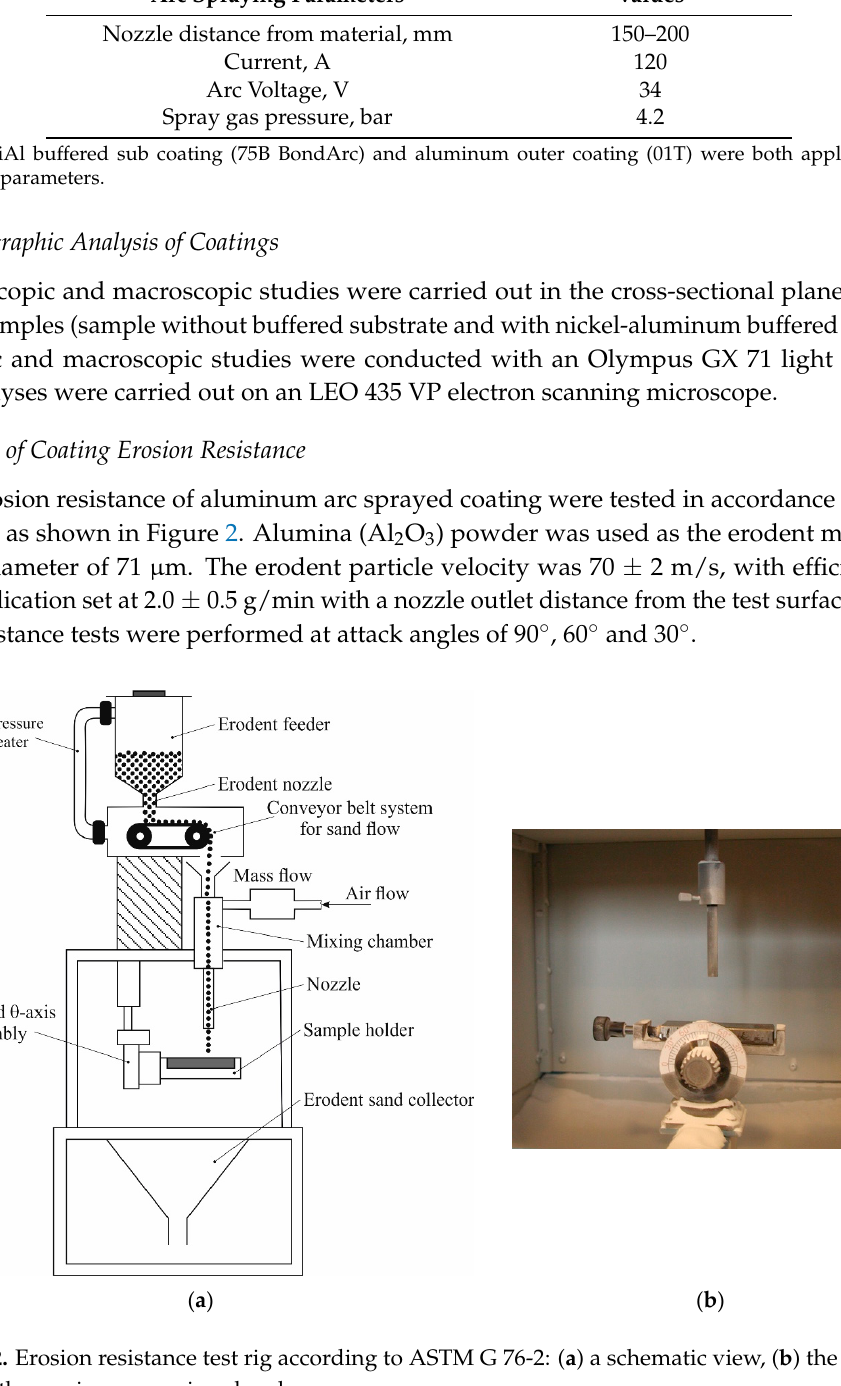
Table 2. Arc spraying parameters for buffered subcoating NiAl 95/5 and aluminum outer coating applied to Armox 500 T.